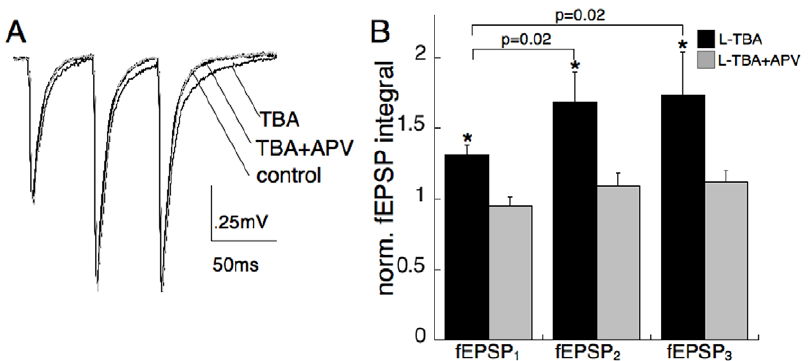
Figure 5. Actions of L-TBA on field responses at the CA1 Schaffer collateral-pyramidal neuron synapse. (A) Representative field EPSPs elicited in response to three stimuli delivered at 20 Hz in stratum radiatum. 30 m M L-TBA (black trace) prolonged fEPSPs relative to control (gray trace) in an activity-dependent manner (p=0.02). The TBA prolongation was inhibited by co-application of 50 m M DL-APV (2nd black trace). (B) Summary of effects on fEPSP time-integrals elicited by 1, 2 and 3 stimuli normalized to corresponding fEPSPs in control ACSF (*p , .05 paired t-test; n=9 slices for one and two stimuli, n=5 slices for three stimuli).